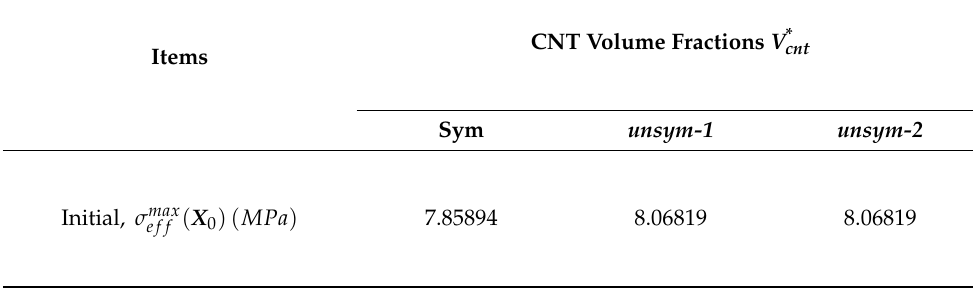
Table 4. The optimization results for three different porosity distributions ( e = 0.2).